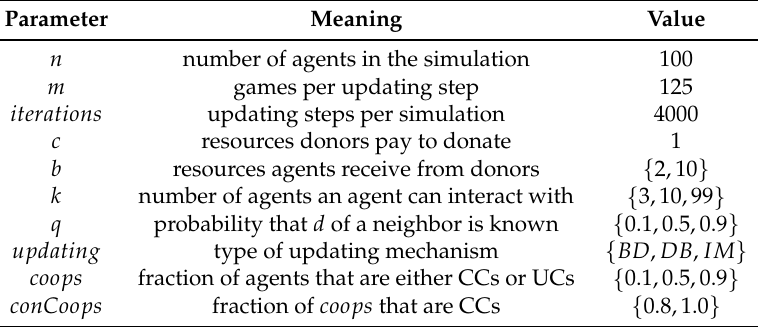
Table 3. Parameters and their possible values in our simulations. CC, conditional cooperator; UC, unconditional